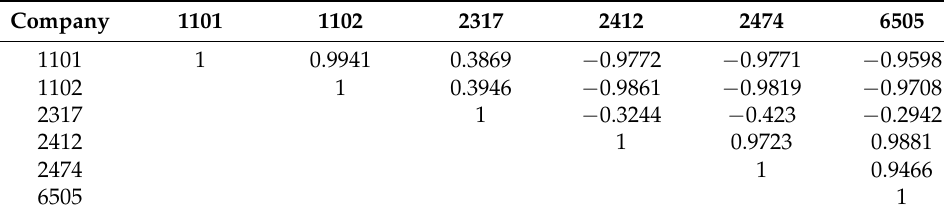
Table 6. Correlation coefficient matrix of six